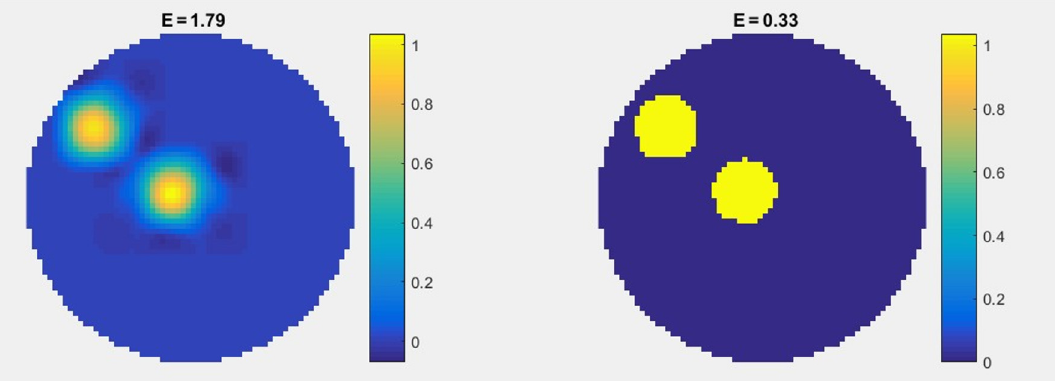
Figure 12. Filtering and image segmentation.